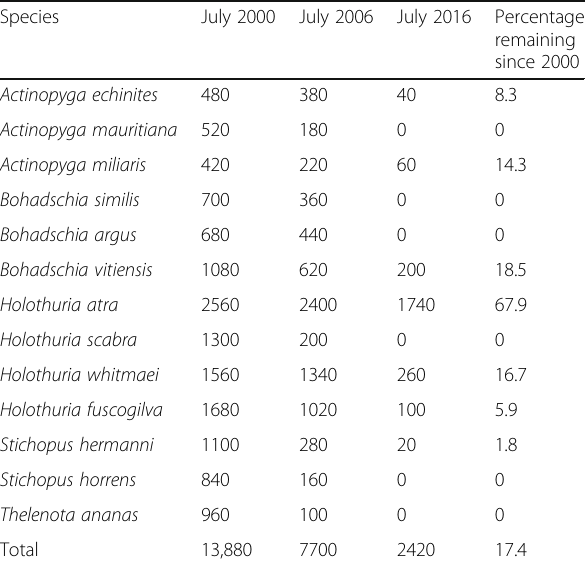
Table 3 Abundances of different sea cucumber populations recorded during the period of study (2000 – 2016) at